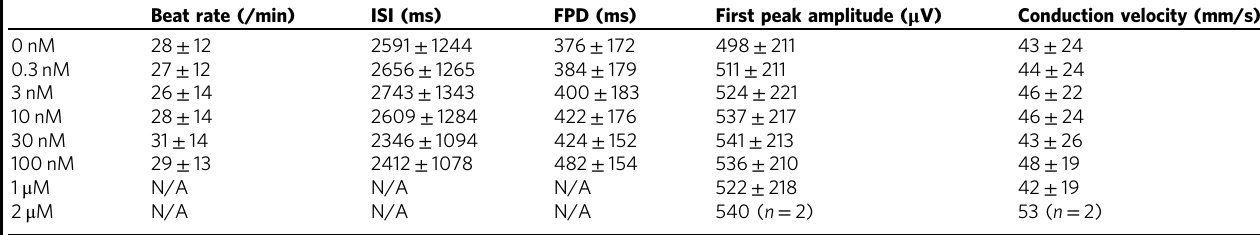
Table 1 Parameters of fi eld potential measurements after E-4031 treatment in CTSs with 50% cardiomyocytes ( ± s.d., n = 4)